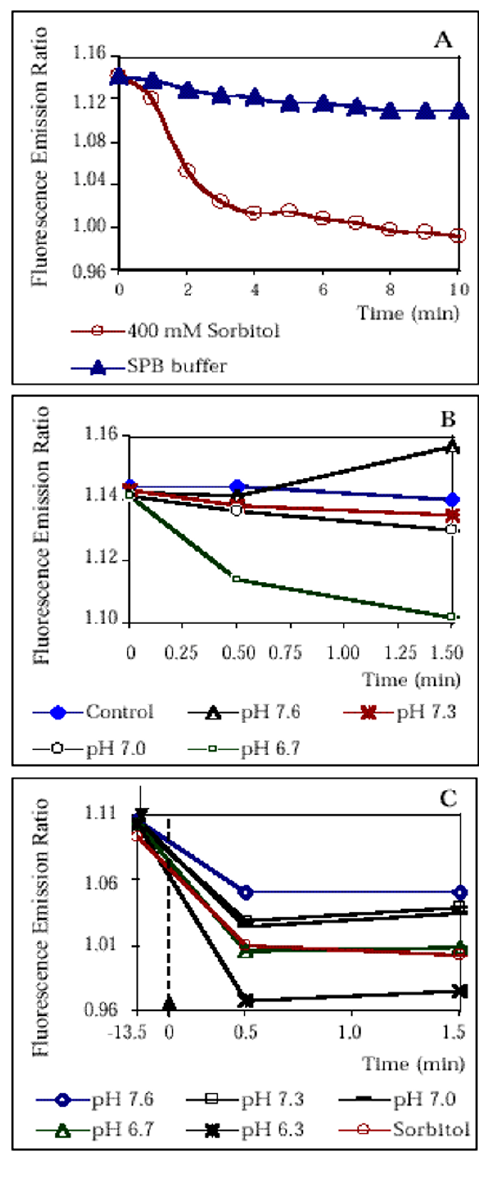
Figure 1 FACS measurements using BCECF as fluorescent pH indicator show that hyperosmotic stress results in intra- cellular acidification (A) AX-2 cells were labeled with BCECF and were subsequently exposed to hyperosmotic stress. Flu- orescence emission was determined at FL1 and FL2 by flow cytometry and the fluorescence emission ratio FL1/FL2 was calculated. The decrease in FL1/FL2 of cells exposed to hyperosmotic shock ("400 mM Sorbitol") reflects a decrease in pH. As control, the measurements were performed with cells suspended in SPB buffer. (B) Calibration of intracellular pH of cells in low osmolarity buffer. BCECF-labeled cells were suspended in calibration solutions with different Pseudo-Null pH values [25] and FL1/FL2 was determined by flow cytometry at intervals. The solution with Pseudo-Null pH 7.3 slightly decreased FL1/FL2 compared to the control cells suspended in SPB buffer and the solution with Pseudo-Null pH 7.6 increases FL1/FL2 compared to the control. Hence, the actual intracellular pH is estimated to be pH 7.3 to pH 7.4. (C) Calibration of the pH of hyperos- motically shocked cells. After BCECF labeling, Dictyostelium cells were suspended SPB buffer and FL1/FL2 was determined at T=-13.5 min. Sorbitol solution was added (indicated by the upper arrow) and the cells were incubated for 10 min. The cells were centrifuged and resuspended in high osmolarity calibration solutions with different Pseudo-Null pH values at T = 0 min (indicated by the lower arrow). FL1/FL2 was determined by flow cytometry at intervals. The solution with Pseudo-Null pH 6.7 slightly decreased FL1/FL2 compared to the control ("Sorbitol"; cells suspended in SPB buffer/400 mM sorbitol) at T = 0.5 min, before intracellular pH starts to recover. This suggests, that the actual intracellular pH is 6.7-6.8. The points of time specified in Fig. 1C are not drawn to